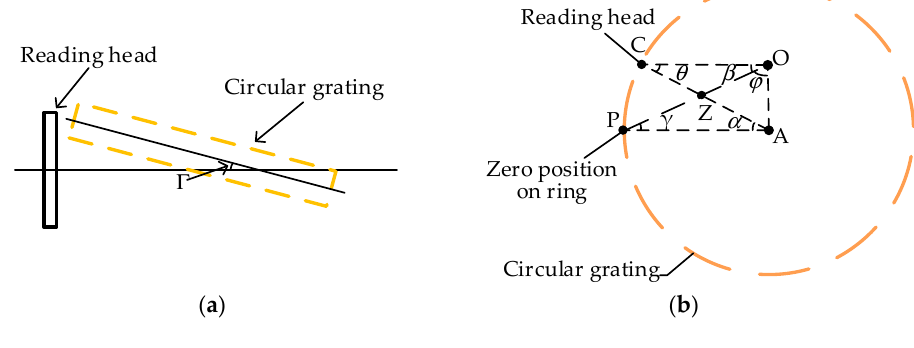
Figure 2. ( a ) Tilt error; ( b ) eccentricity error.